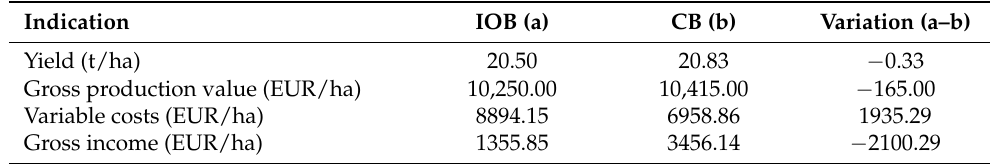
Table 6. Economic values of broccoli growing